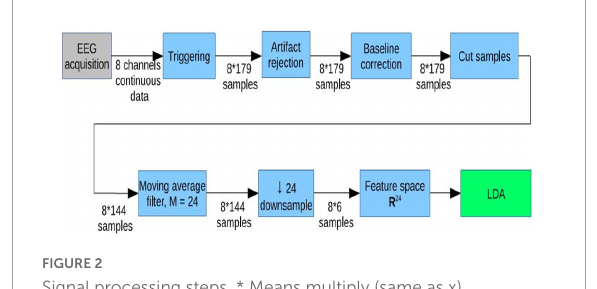
FIGURE2 Signal processing steps. * Means multiply (same as x).